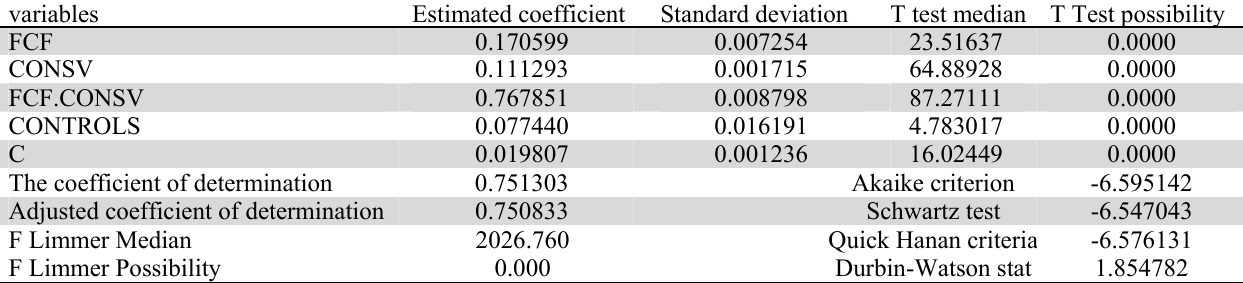
Evaluation of relationship between investment returns and conservatism variables